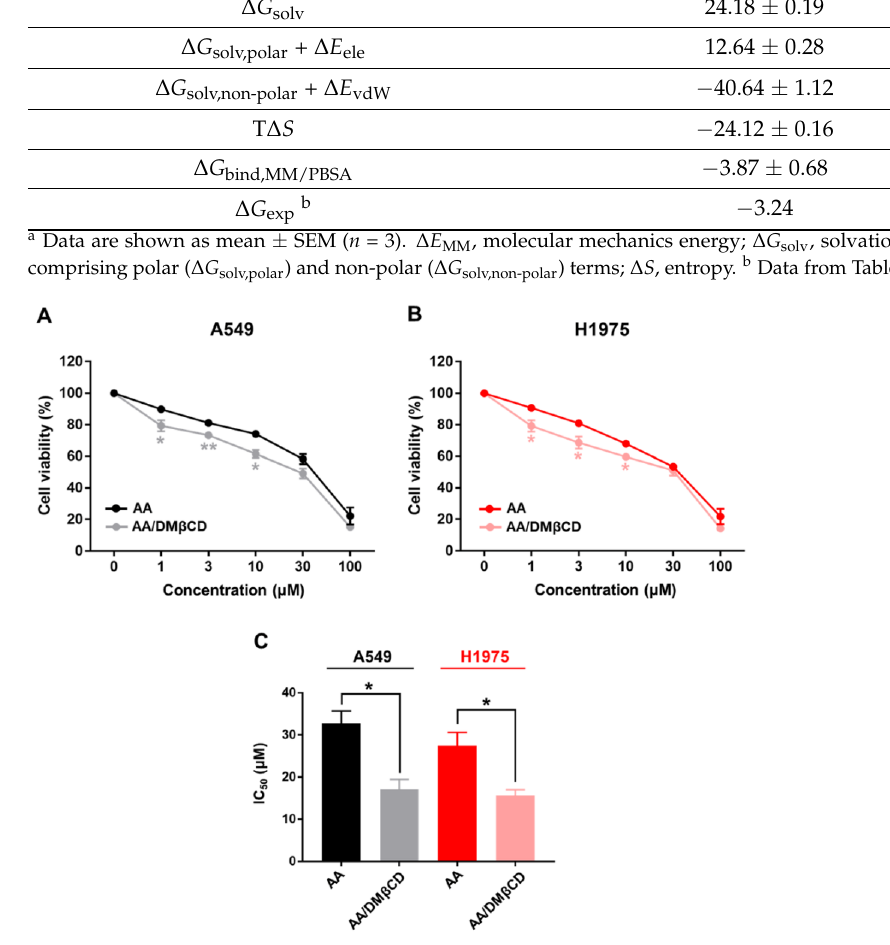
energy comprising polar ( ∆ G solv,polar ) and non-polar ( ∆ G solv,non-polar ) terms; ∆ S , entropy. b Data from Table 4. ∆ G bind, MM/PBSA and its energy components (kcal/mol) of the AA/DM β CD complex. Table 2. Energy Component (kcal/mol) a AA/DM β CD 2.4. DM β CD Enhances Cytotoxicity of AA against Lung Cancer Cells ∆ E − 35.12 ± 1.06 The cytotoxic activity of AA and the AA/DM β CD inclusion complex against A549 vdW − 17.05 ± 0.19 and H1975 human lung cancer cells was evaluated using MTT assay. The obtained results are depicted in Figure 10. We found that both AA and AA/DM β CD decreased cell viability − 52.18 ± 0.92 in a dose-dependent manner, in which the AA/DM β CD complex exhibited significantly 29.69 ± 0.16 lower cell viability than the uncomplexed AA at the concentration of 1, 3, and 10 μ M for both A549 and H1975 cell lines (Figure 10A,B). The half-maximal inhibitory concentration (IC 50 ) values against the A549 and H1975 cells of the AA/DM β CD inclusion complex (17.14 ± 2.34 and 15.67 ± 1.33 μ M) were significantly lower than those of the AA alone (32.77 ±